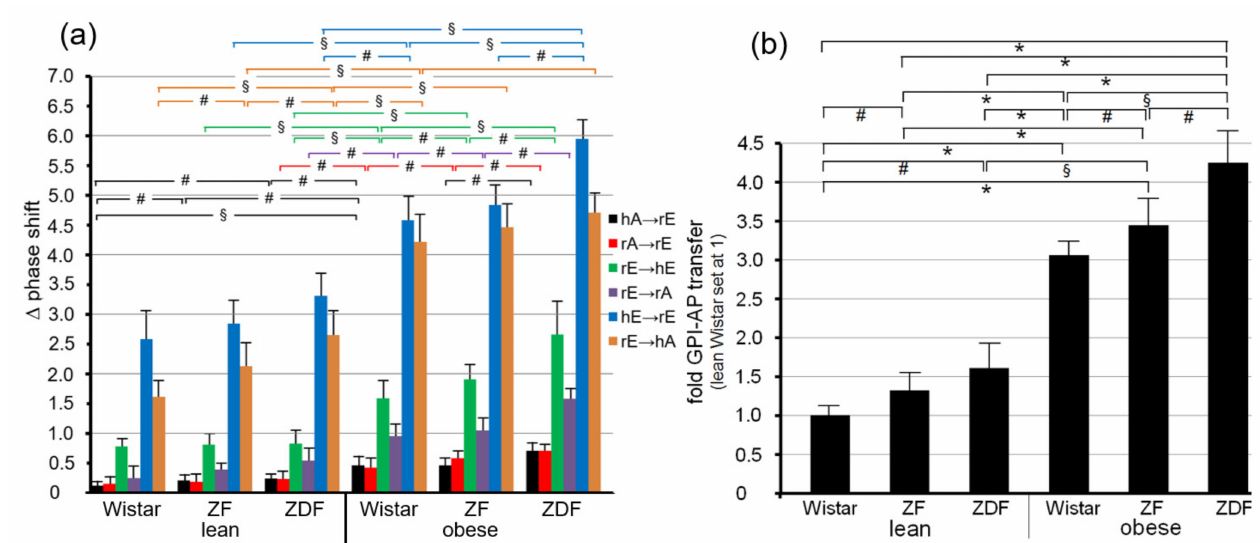
Figure 7. Comparative quantitative evaluation of the six rat groups for transfer of full-length GPI-APs from donor to acceptor PM for the various combinations ( a ) and the calculated means thereof ( b ). The experiment was performed as described for Figure 6 with measurements in quadruplicate (with distinct chips each) for each donor–acceptor PM combination. ( a ) ∆ phase shifts as measure for GPI-AP-induced increases in phase shift are calculated as described for Figure 6 and given as means ± SD for each combination with statistical significance ( § p ≤ 0.02, # p ≤ 0.05; only between rat groups displaying relatively small differences for reasons of clarity). ( b ) Fold GPI-AP transfer was calculated relative to control (acceptor PM only, Figure 6) for each of the six rat groups upon calculation of the means for the donor–acceptor PM combinations for each rat group and normalization of lean Wistar rats (set at 1) as means ± SD with statistical significance (* p ≤ 0.01, § p ≤ 0.02, # p ≤ 0.05 between all rat